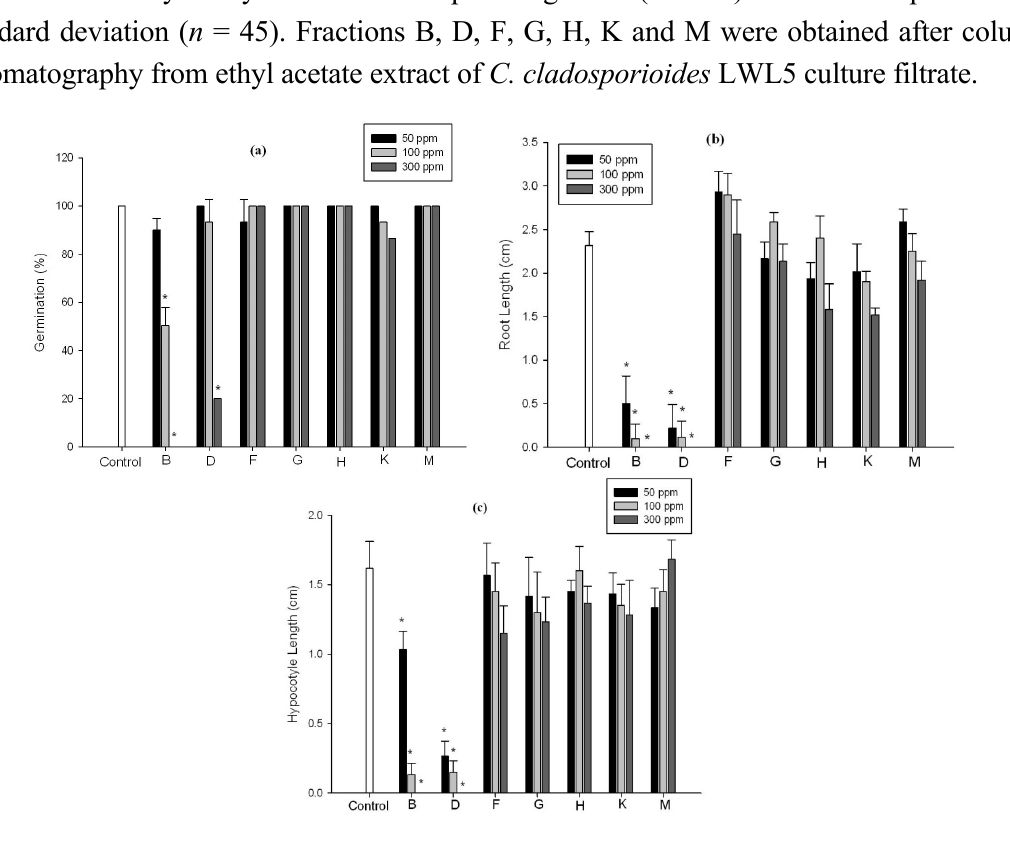
Figure 3. Effect of selected fractions on growth parameters of lettuce seeds. The effect was assessed at 50, 100 and 300 ppm on germination percentage ( a ), root length ( b ) and hypocotyl length ( c ). Star on bars indicates the significant difference at ( p < 0.01) among treatments as analyzed by Duncan’s Multiple Range Test (DMRT). Error bars represents the standard deviation ( n = 45). Fractions B, D, F, G, H, K and M were obtained after column